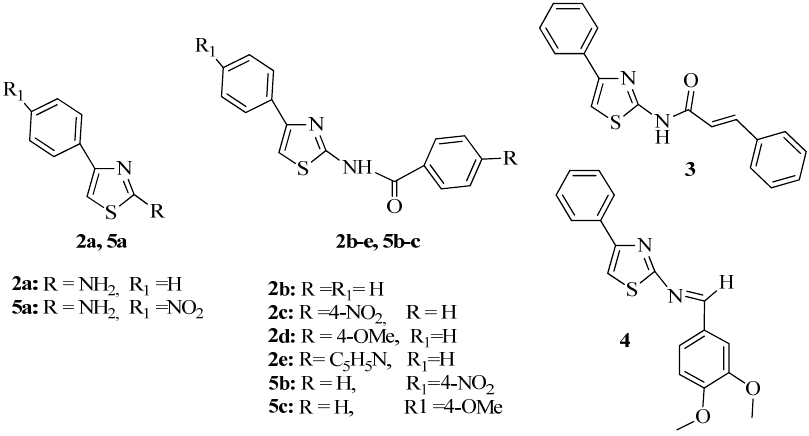
Figure 3. Structure of 2, 4-disubstituted thiazole derivatives.